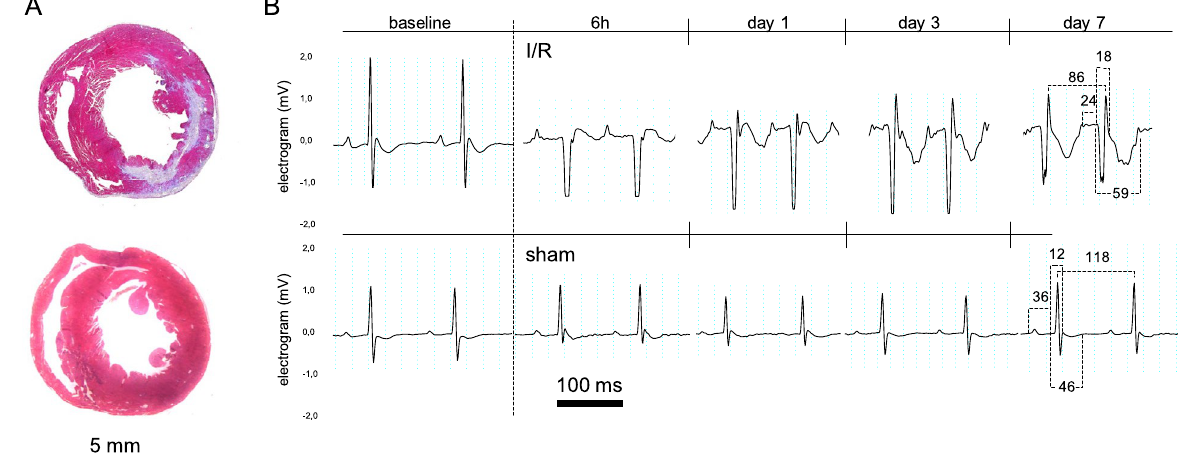
Figure 1. Alterations in surface electrogram after I/R in mice. ( A ) Gomoris trichrome staining of transverse sections at the mid-cavity level of the left ventricle from a mouse 7 days after I/R yielding an infarction size of 33% (upper panel) and a sham control mouse (lower panel). ( B ) Representative telemetric electrogram recordings from a mouse after I/R (upper panel) and after sham operation. Duration of indicated intervals